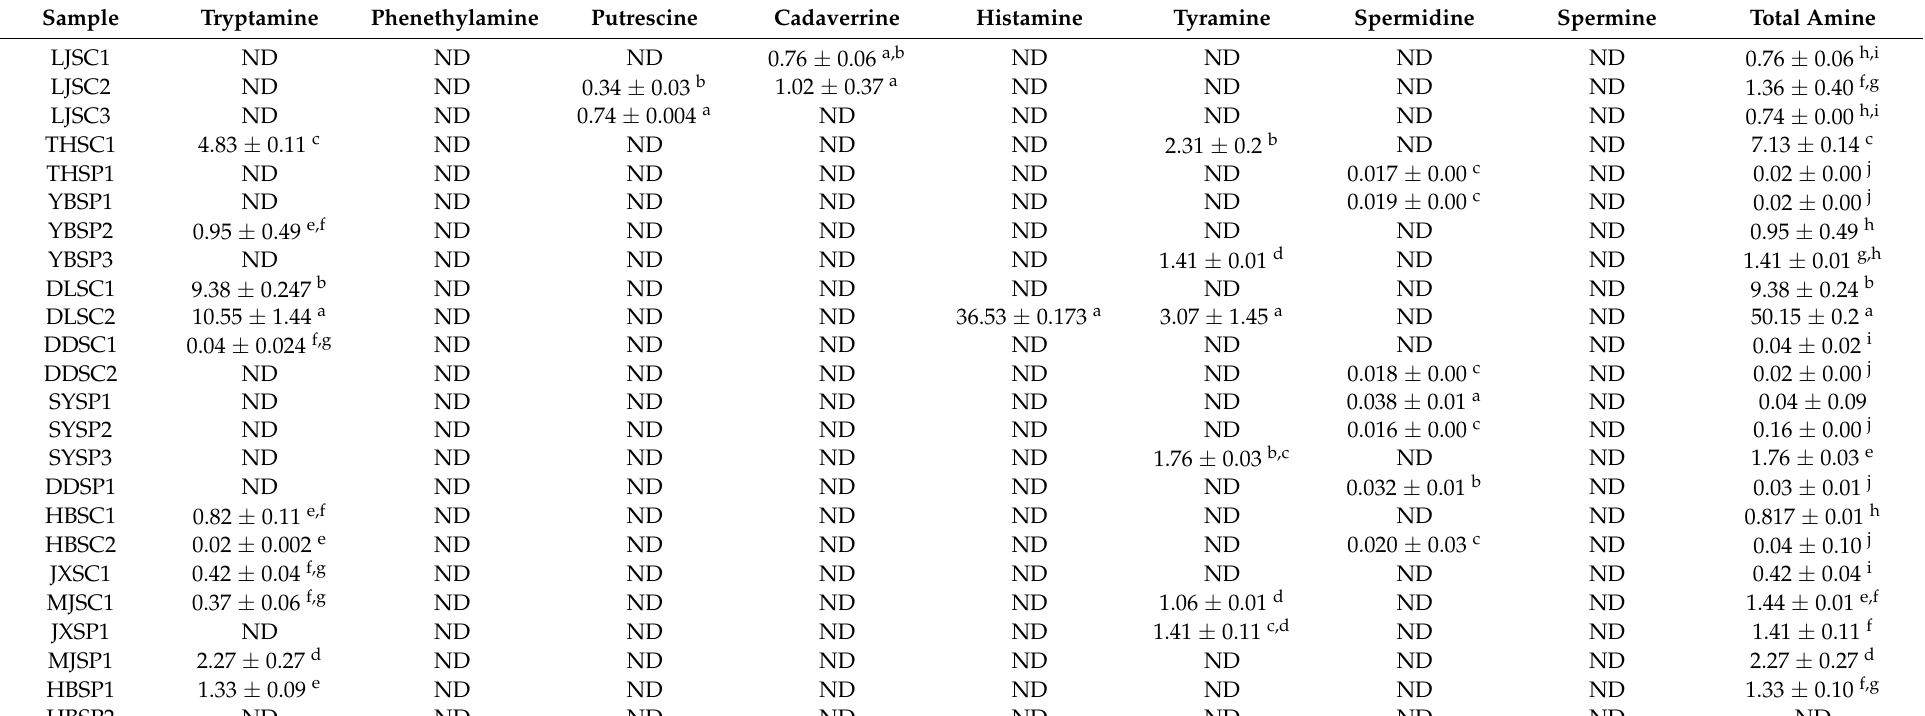
Table 2. Contents of BAs in CSC